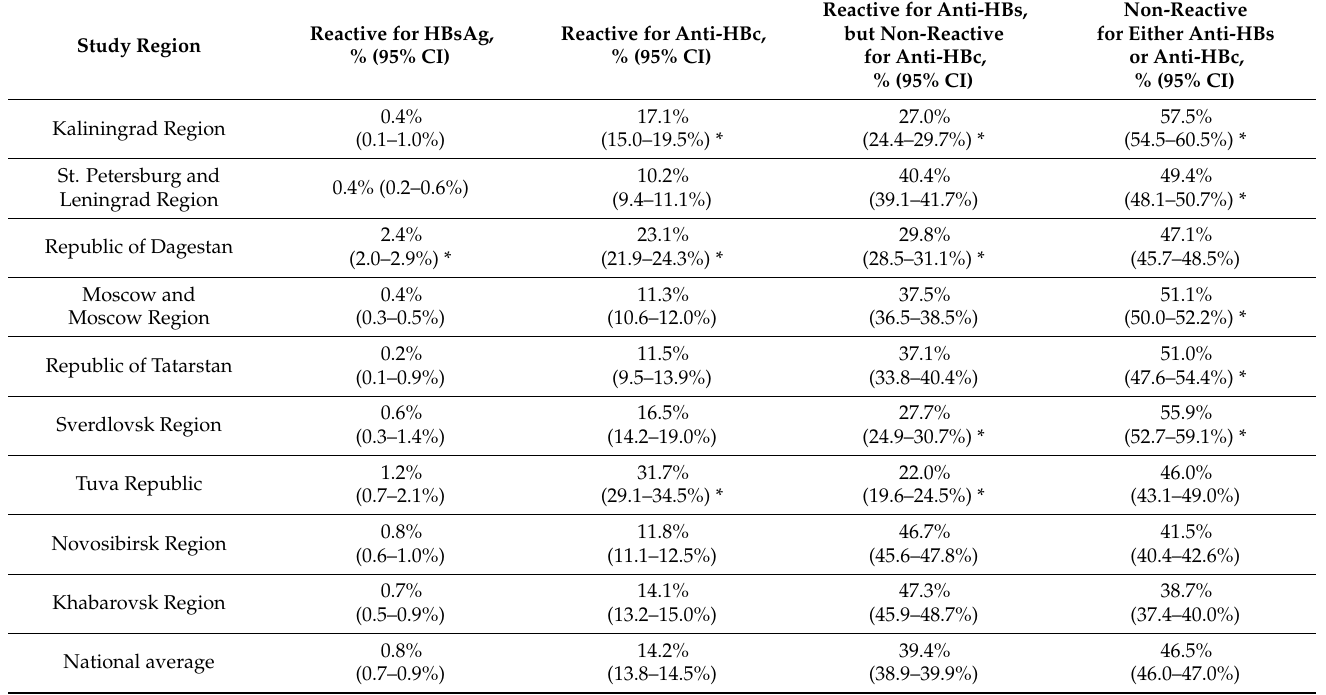
Table 1. Average detection rates of HBV markers in healthy